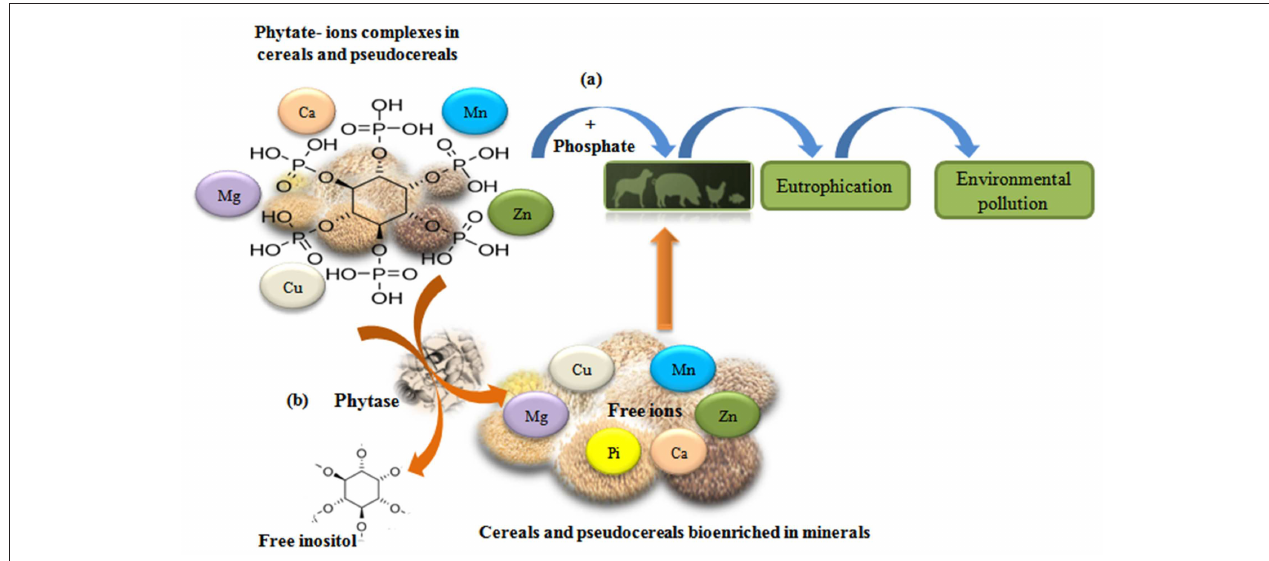
FIGURE 4 | Phytate-ions complexes reduce bioavailability of minerals in cereal and pseudocereals. (a) Phosphorus supplementation in animal feedstuff cause pollution problems. (b) Phytase activity increase mineral biodisponibility and improve nutrition value of foods [adapted from (240)].